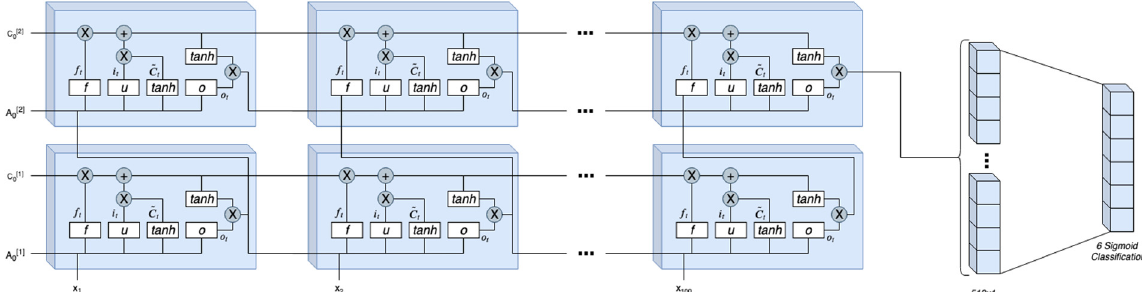
Fig. 5. LSTM RNN architecture proposed for the classi fi cation task, outputting a 512-dimensional representational vector of the input to a 6-unit classi fi cation layer. The LSTM units take in input from the bottom, x t , with all gates depicted in each